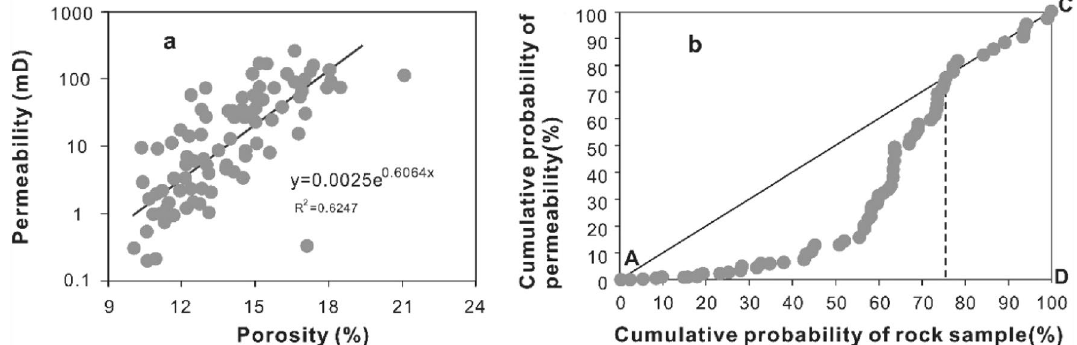
Figure 7. ( a ) Relationship between porosity and permeability. ( b ) Lorenz plot of permeability of K22 set in Z21 oil–gas field. Strong reservoir heterogeneity is indicated by this intergranular pores adjacent to unstable grains, such as feldspar (Fig. 8c). In some cases, quartz overgrowth is observed. The clay minerals (average 5.27%) are dominated by kaolinite, appearing as stacked booklets or vermiform aggregates (Fig. 8d). They are usually distributed in the residual primary intergranular pores or incompletely filled by other cements, such as calcite cements (Fig. 8d). Fibrous (Fig. 8e) or honeycomb-like illite with spiny terminations (Fig. 6d) is also abundant in the target sandstones. Stochastically oriented platelet-shaped chlorites mostly occur along the rims of grains (Fig. 8f). The relative contents of kaolinite, illite and chlorite range from 0 to 82%, 0–55%, and 0–68%, respectively. Calcite (average 6.81%) is the most widely distributed carbonate cement in the Miocene Zhujiang Formation sandstones. In thin section, calcite completely plugging the intergranular pores is occasionally observed (Fig. 8g). However, in most cases, calcite cements partially fill the intergranular pores (Fig. 8d). Fibrous dawsonite aggre- gates are occasionally observed filling the intergranular pores (Fig. 8h).